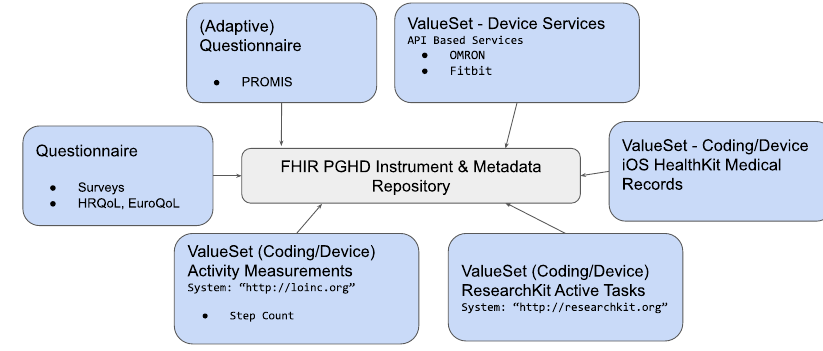
Fig. 2 FHIR-based repository storing codi fi ed identi fi ers for different types of PGHD